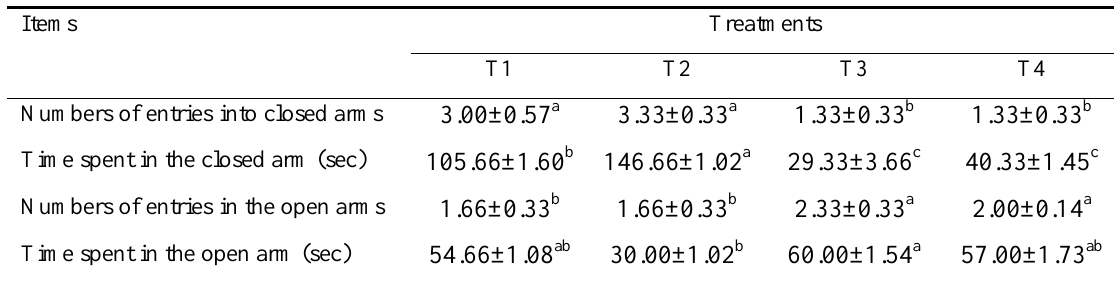
Table 3: The impact of aqueous extract of Eruca sativa leaves on healthy and thioacetamide intoxicated mice anxiety (mean ± SE):